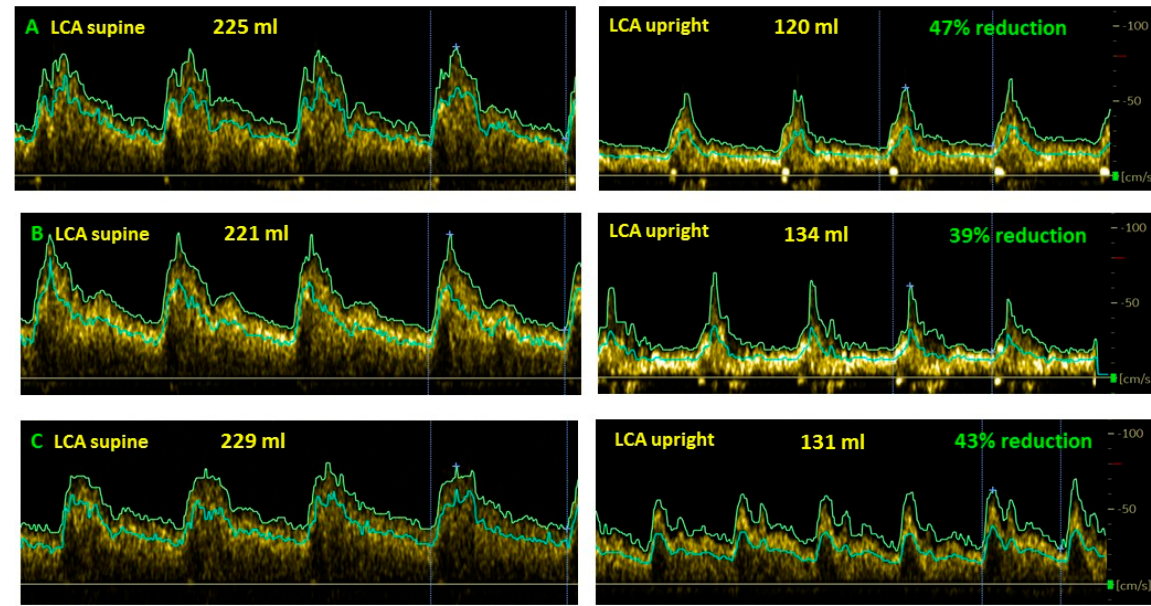
Figure 2. Frequencies of orthostatic intolerance complaints after tilting, as assessed by a question- naire, in long-haul COVID cases (red), in ME/CFS controls triggered by EBV (yellow) and in ME/CFS controls with an insidious onset (green).